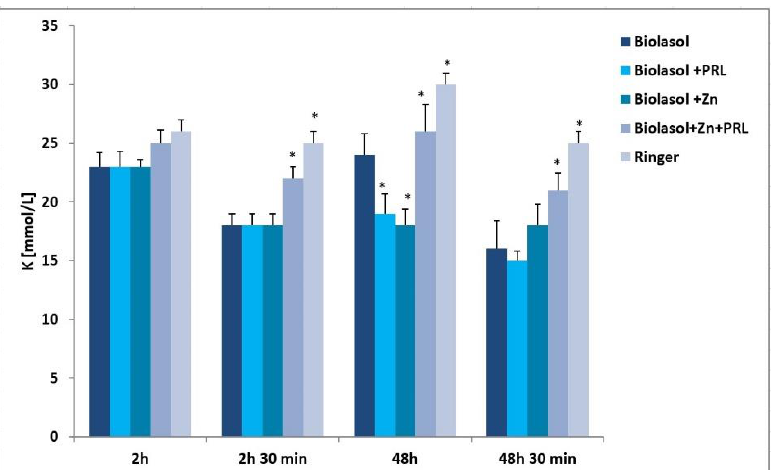
Figure 5. Potassium concentrations in the collected perfusates and reperfusates in model of storing isolated porcine kidneys. The values are expressed as mean ± SEM. Data were analysed by one-way ANOVA and Bonferroni post hoc tests; n = 10; * p < 0.05 compared to the control group (Biolasol).